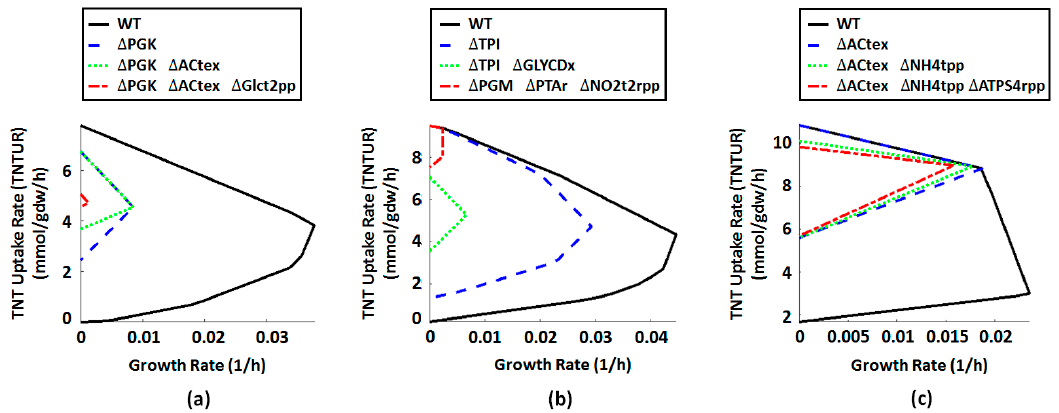
Figure 13. Growth envelope for various TNT uptake strain designs during growth on ( a ) glucose; ( b ) glycerol; and ( c ) ethanol.